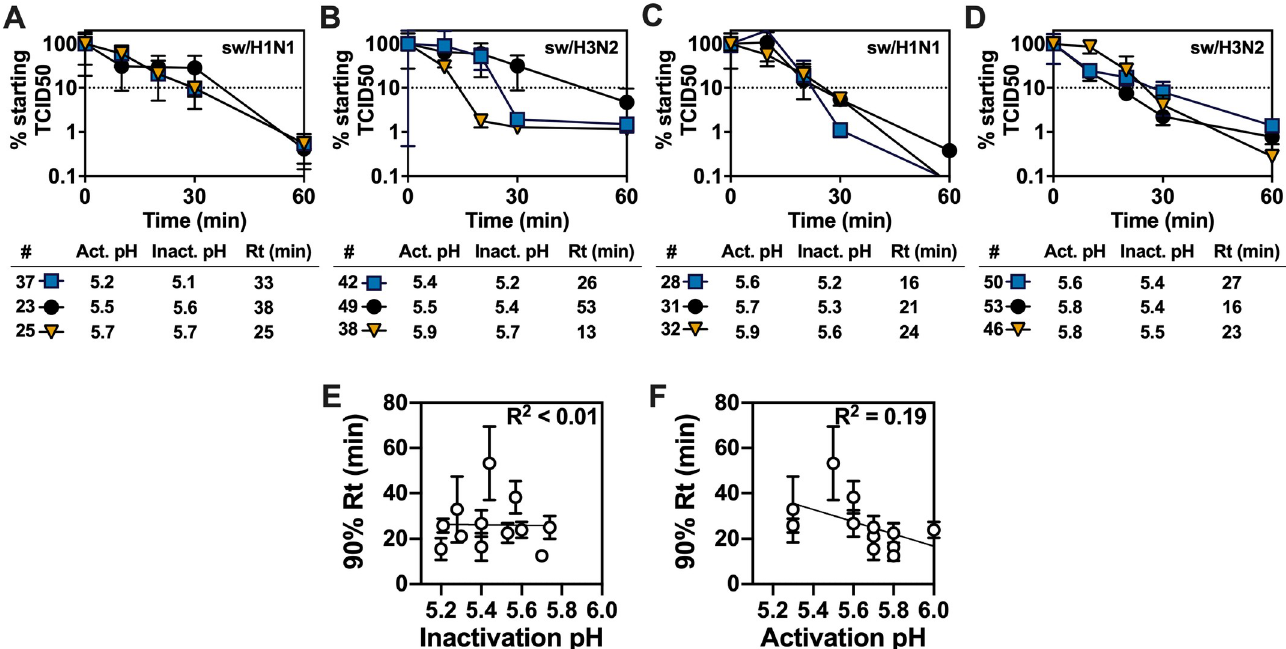
Fig 9. Virus thermostability of swine H1N1 and H3N2 isolates and its relationship to pH stability. (A-D) Residual infectivity (normalized TCID50) determined for virus-containing aliquots incubated at pH 7.0 for the reported times at 55˚C. Virus numbers and their associated symbols, HA activation pH, inactivation pH, and Rt values are listed below each panel. The 10% (dotted) line corresponds to a 90% reduction of starting infectivity. (E-F) Virion inactivation pH and HA activation pH values compared to calculated 90% Reduction time (Rt) values measured at 55˚C. Representative data from a repeated experiment is shown. Data were analyzed by simple linear regression using GraphPad Prism 8 and calculated R 2 values are reported in the top-right corners.